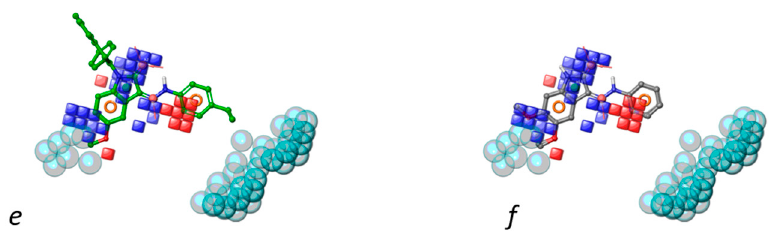
Figure 6. Contour maps rendered as blue and red cubes indicate positive and negative regions for activity. Specifically, panels ( a , c , e ) show the most active ligands within hydrophobic, HBD and electron withdrawing region, respectively; panels ( b , d , f ) show the most inactive ligands within hydrophobic, HBD and electron withdrawing regions, respectively. Pharmacophore features and excluded volumes are also reported.